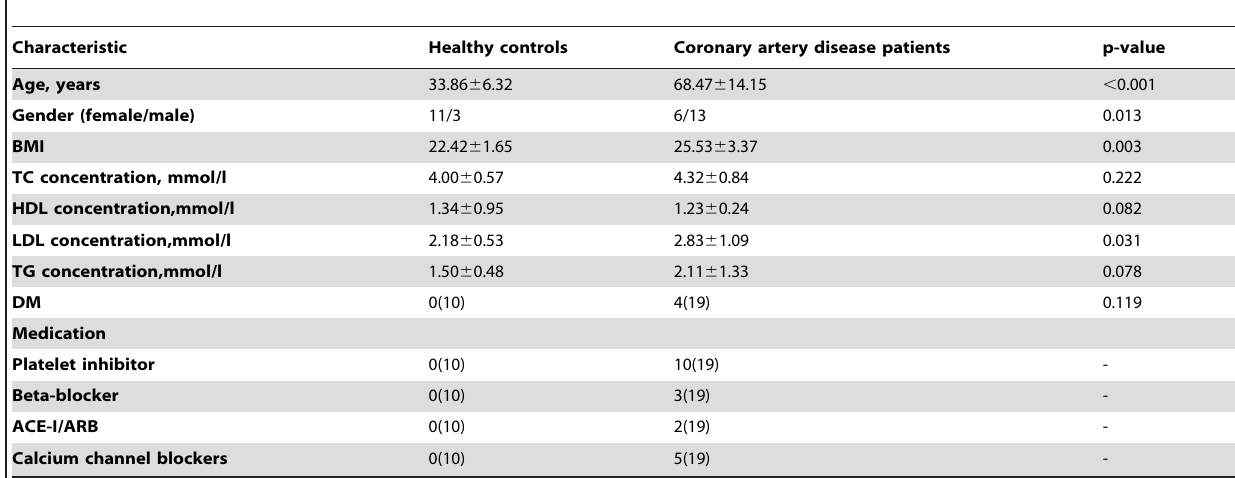
Table 2. Clinical data of healthy subjects and coronary artery disease patients.